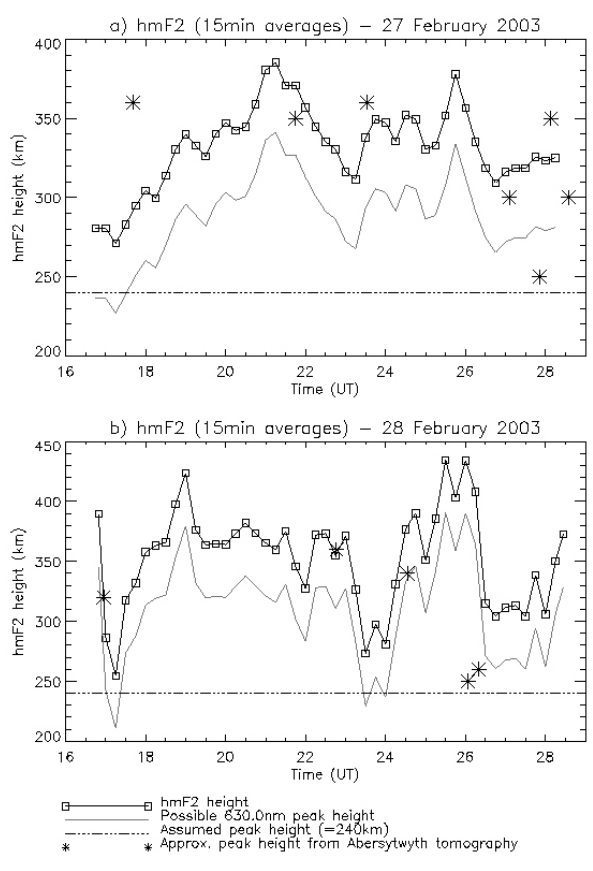
Fig. 12. Variation of hm F2 on the nights of (a) 27–28 February 2003 and (b) 28 February–1 March 2003 from EISCAT and tomography data. It is assumed that the 630-nm peak emission height is 240km (dot-dashed line). This assumption is compared with an assumption that the peak height is about 50km below hm F2 (dotted